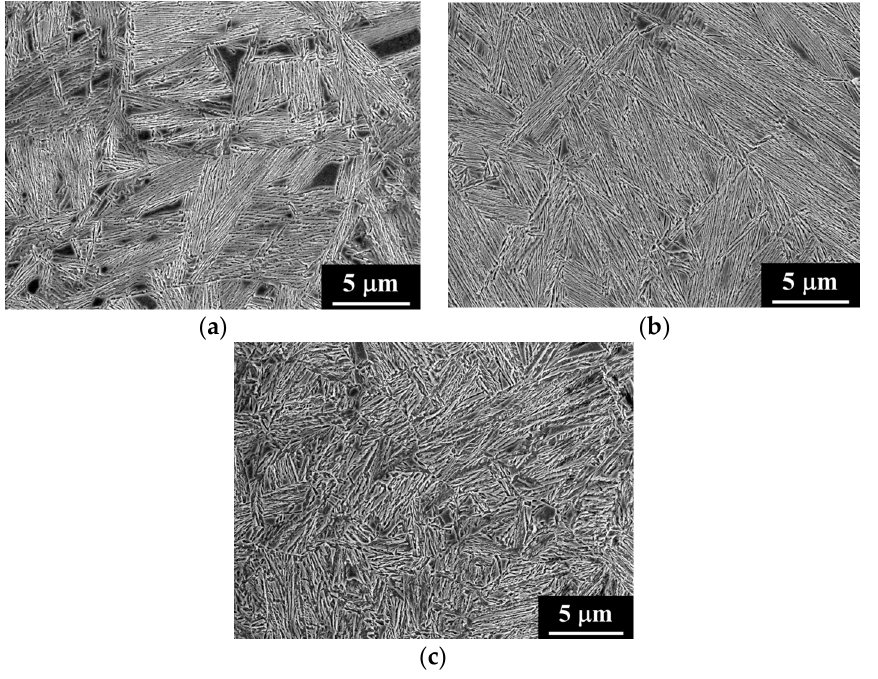
Figure 4. FEG-SEM micrographs for ( a ) 1C-2.5Si-950-250-16; ( b ) 1C-2.5Si-950-250-40; and ( c ) 0.6C-1.5Si-890-250-16 specimens.